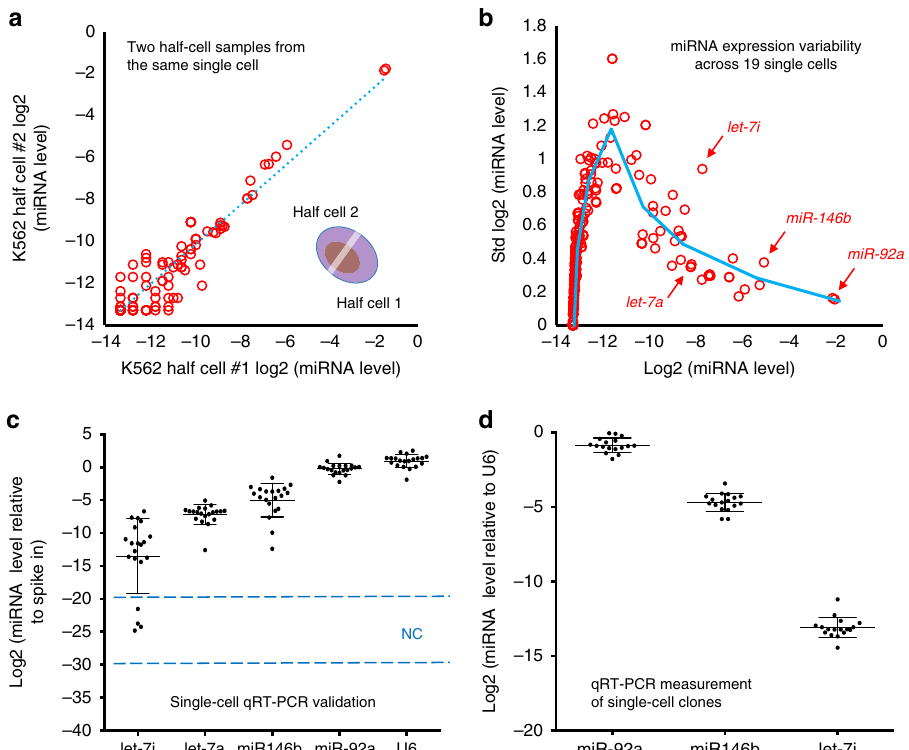
Fig. 2 Pro fi ling of miRNAs from half-cell lysate. a A single K562 cell was lysed, and two halves of the lysate were separately subjected to small RNA sequencing. Scatter plot of normalized and log2-transformed miRNA expression levels (miRNA expression levels represent the fraction among total miRNA, see Methods) is shown. Each circle represents one annotated miRNA. The correlation coef fi cient R 2 = 0.93. b The standard deviations (on y -axis) of miRNA expression across 19 successfully pro fi led half cells were plotted against the mean expression on x -axis, using normalized and log2-transformed miRNA expression data as described in a . Each circle represents one annotated miRNA. The blue line shows the trend of the distribution based on locally averaged values. Speci fi c miRNAs are highlighted with red arrows. c Validation experiment was carried out by quantifying miRNA expression in 20 single K562 cells using qRT-PCR. Relative levels of let-7i-5p, let-7a-5p, miR-146b-5p, miR-92a-3p, and U6 were determined relative to a spike-in control (synthetic miR-371). Each dot represents one K562 cell. Each data point re fl ects the average measurements from two technical replicates. Error bars present standard deviation. N = 20. The levels of miRNA are shown in log2 scale. The dashed lines and NC (negative control) indicates the detection range of water samples. d Single K562 cells were grown to derive 17 clones, and the relative levels of miR-92a-3p, miR-146b-5p, and let-7i-5p were determined in clonal populations by qRT-PCR. Roughly 40,000 cells were used from each clone. Each dot represents one K562 clone. Each data point re fl ects the average from two technical replicates. Error bars present standard deviation. N = 17. U6 was measured as a control for normalization. The levels of miRNAs are shown in log